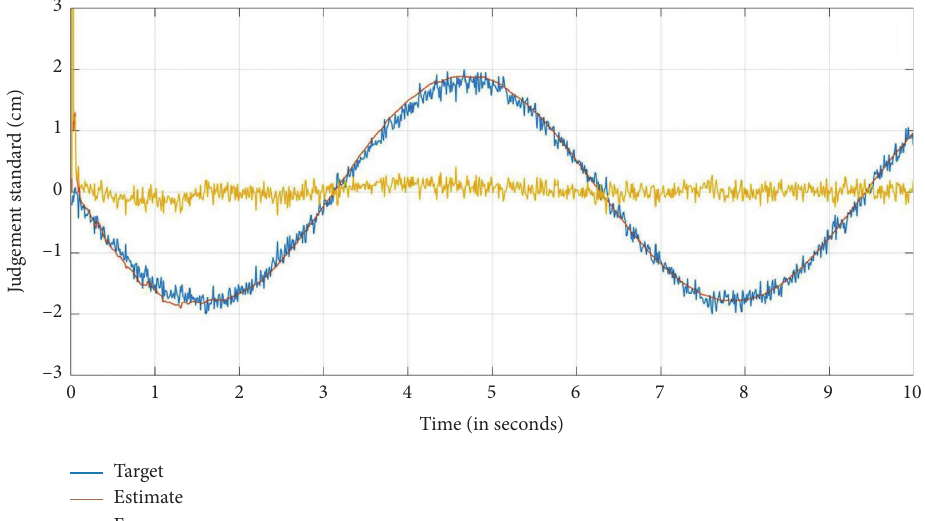
Figure 7: Comparison of system parameter identification. The error is the difference between the target value and the estimated value.